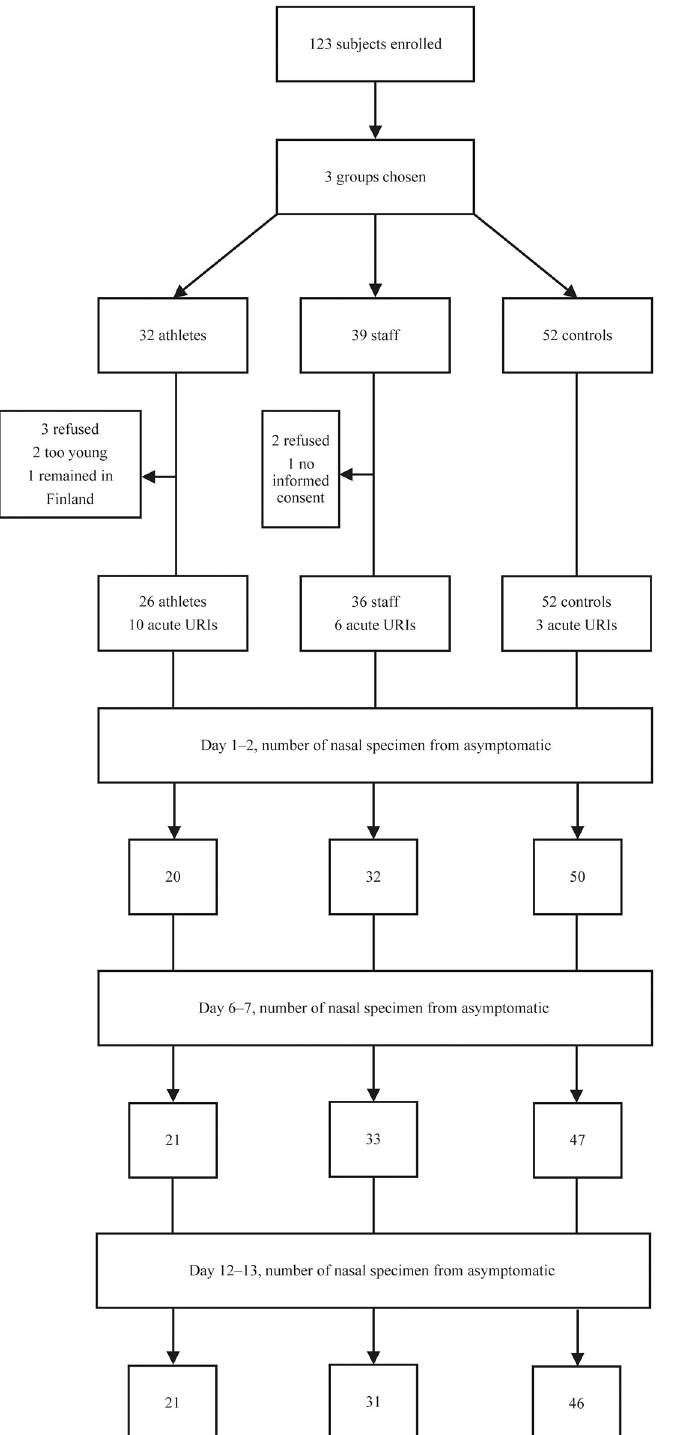
Fig 1. Flow chart of the study. a URI, upper respiratory infection.